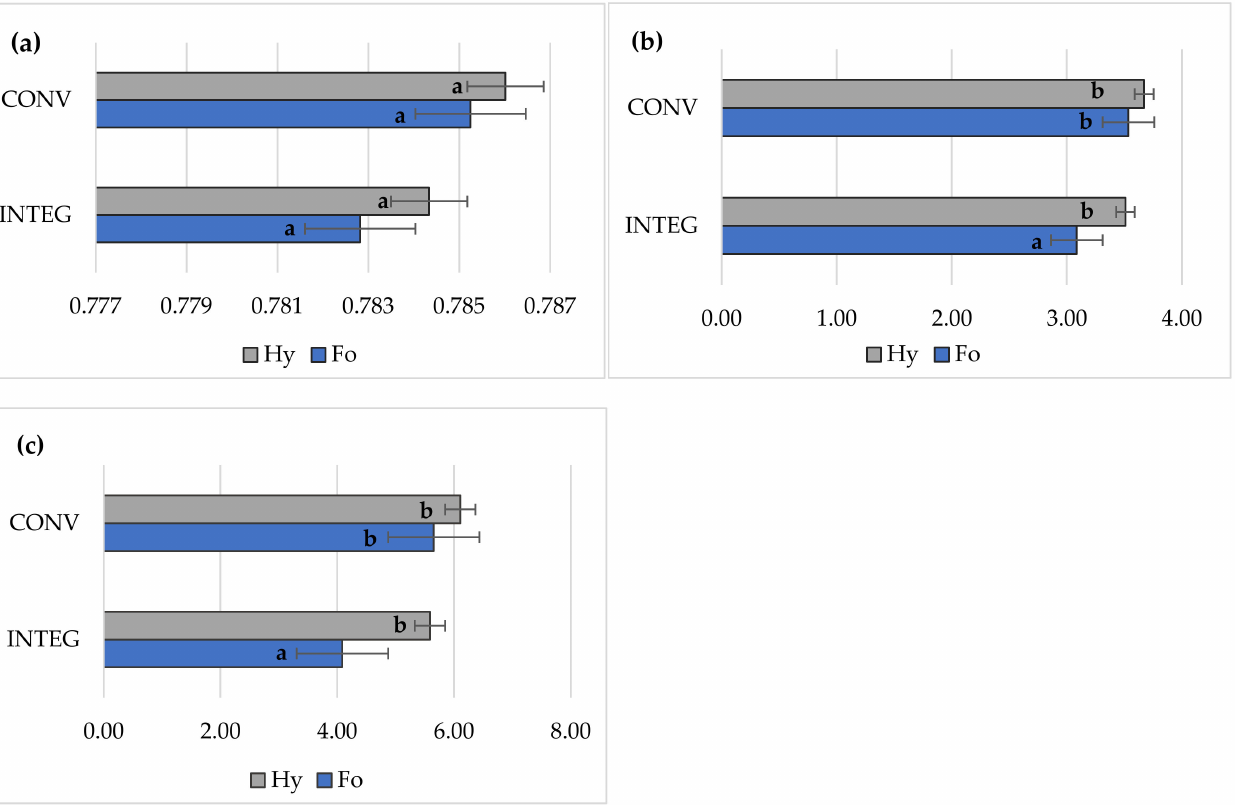
Figure 5. ( a – c ) Selected chlorophyll fluorescence parameters depending on cultivars and crop- ping systems. ( a ) F v /F 0 —the maximum quantum yield of primary photochemistry, ( b ) F v /F m — maximum quantum yield of PSII photochemistry, and ( c ) PI—performance index. The presence of different lowercase letters indicates a statistical difference between means (Tukey’s Test, p =